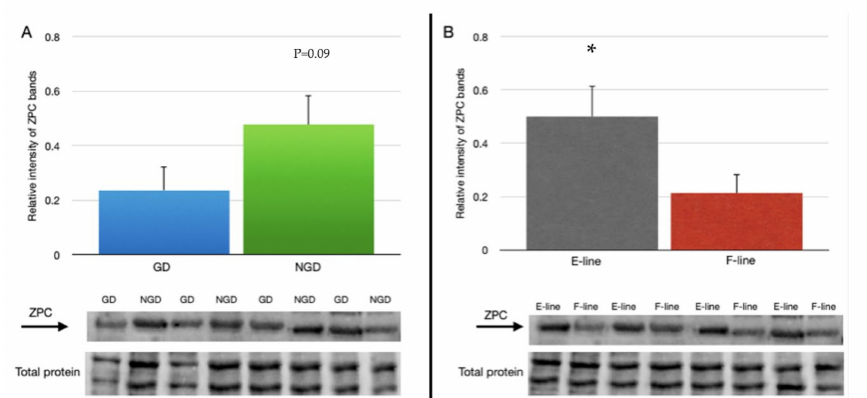
Figure 3. Relative abundance of ZPC protein in the perivitelline layer of laid eggs between ( A ) the non-germinal disc (NGD) region and germinal disc (GD) region with a representative blot for ZPC comparing GD and NGD regions and the section of total protein used for normalization. ( B ) Relative abundance of ZPC in the perivitelline layer of laid eggs between two genetic lines of turkey hens selected for either egg production (E-line) or rapid body growth (F-line) along with a representative blot for ZPC and total protein. For ( A ), n = 12 replicate samples per perivitelline location (6 E-line eggs plus 6 F-line eggs), and for ( B ), n = 12 replicate samples (6 GD plus 6 NGD) per genetic line. Values represent the mean ± SEM. * indicates significant difference in means, p < 0.05.